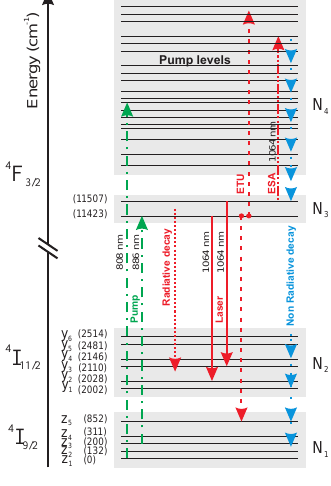
Figure 2. A detailed view of the Nd:YAG energy levels and transitions in the TWM. ation of electrons from the pump levels manifold to the upper laser manifold is fast compared to the rates of optical pump absorption and typical duration of generated giant laser pulses (it is assumed that non radiative decay time τ 43 is less than 1